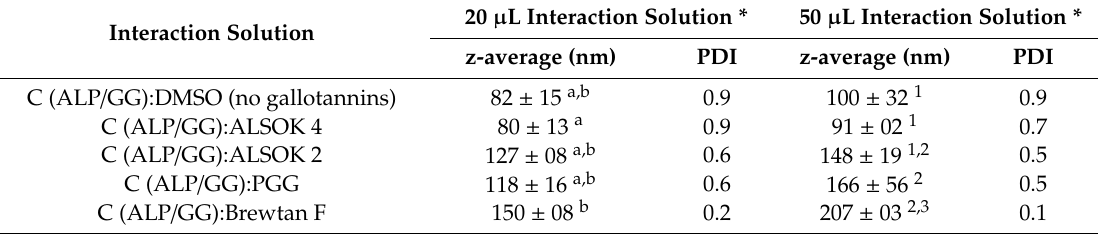
Table 2. Dynamic light scattering (DLS) measurements (z-average and polydispersity index (PDI)) of ALP aggregates in interaction solution C (see Table 2). In all cases, n =